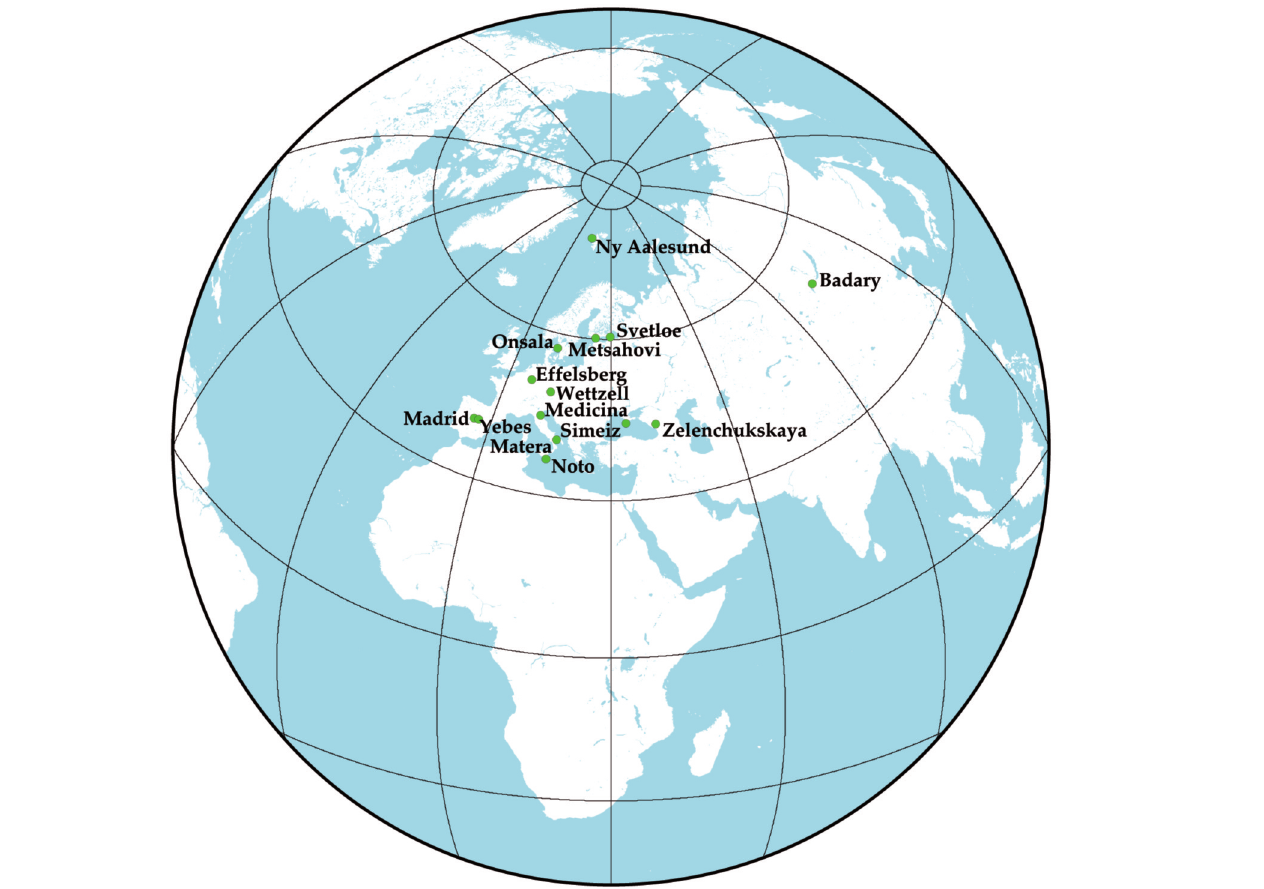
Figure 1. The European VLBI network currently operating in the framework of EUROPE-VLBI